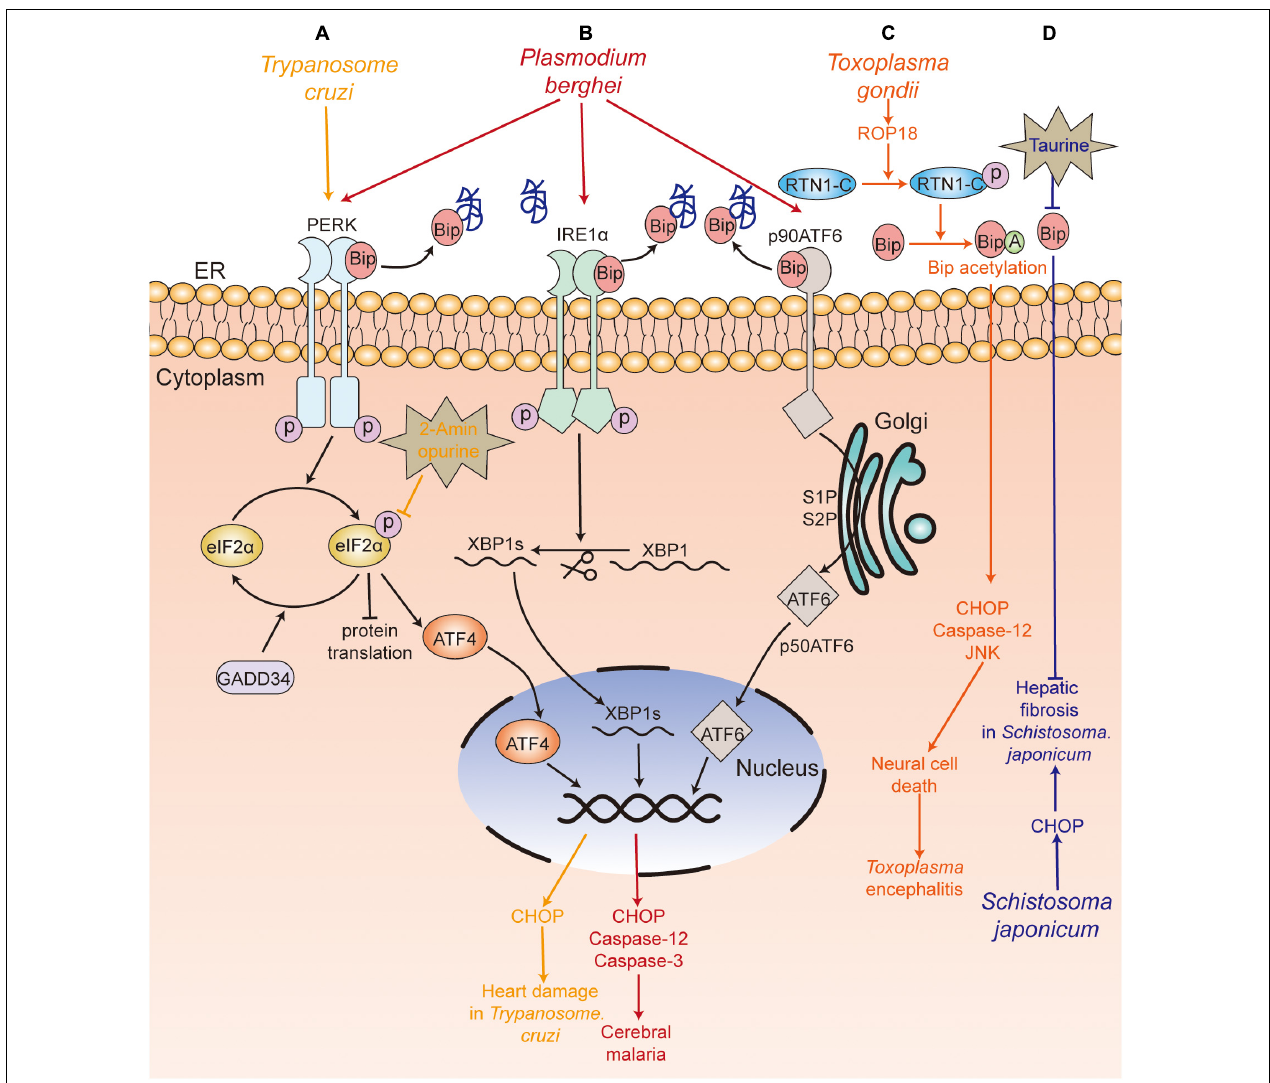
FIGURE 2 | UPR participates in the pathological damage caused by parasite infection. (A) T. Cruzi (yellow) infection caused heart damage, with upregulation of PERK-eIF2 α -ATF4-CHOP pathway, and 2-aminopurine treatment alleviated the heart’s pathological damage. (B) P. berghei (red) infection induced neuronal cell death and caused experimental cerebral malaria by activating the three branches of the UPR (PERK-eIF2 α -ATF4/GADD34, IRE1-XBP1s, ATF6). (C) Rhoptry protein 18 (ROP18) of T. gondii (orange) phosphorylated reticulon 1-C (RTN1-C), which led to the acetylation of GRP78 and further upregulated the expression of cleaved caspase-12, CHOP, cleaved caspase-3, and induced the apoptosis of neural cells. (D) S. japonicum (blue) infection led to increased levels of CHOP, which was involved in hepatic fibrosis, and the treatment with taurine suppressed the egg-induced hepatic granuloma and fibrosis. PERK, protein kinase RNA-like ER kinase; IRE1, inositol-requiring kinase/endoribonuclease 1; eIF2 α , α -subunit of eukaryotic translational initiation factor 2; ATF6, activating transcription factor 6; ATF4, activating transcription factor 4; XBP1, X box-binding protein 1; CHOP, C/EBP-homologous protein; Bip, immunoglobulin heavy chain binding protein;GADD34, DNA damage-inducible